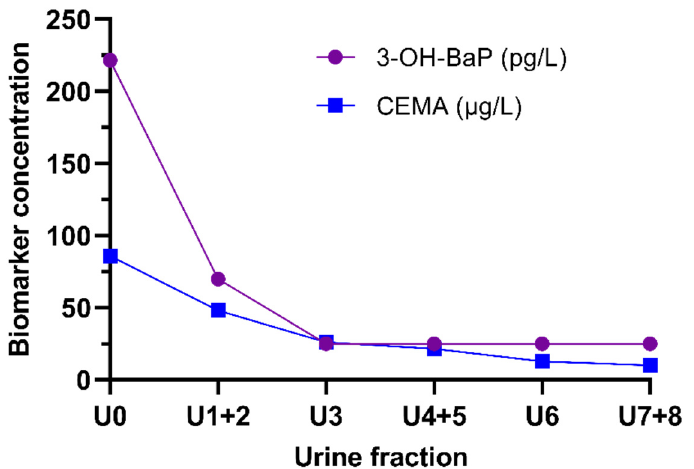
Figure 6. Progression of 3-OH-BaP (pg/L) and CEMA (µg/L) concentration of an NRT user over the three study days.